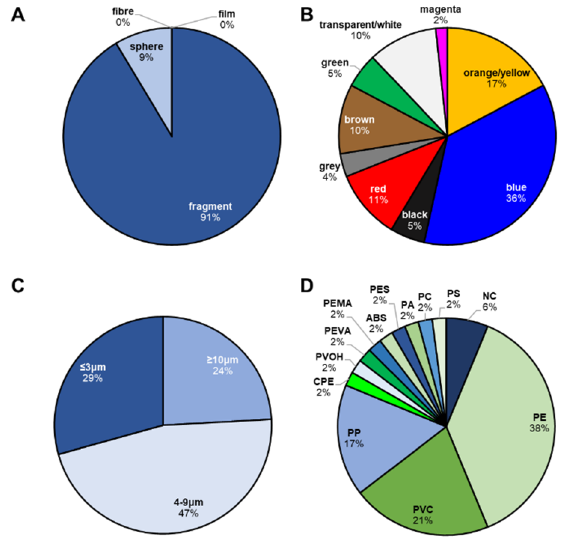
Figure 2. Percentage abundances of identified shapes ( A ), colours ( B ), dimensions ( C ), and polymer matrices ( D ). PE: polyethylene; PVC: polyvinyl chloride; PP: polypropylene; CPE: chlorinated polyethylene; PVOH: polyvinyl alcohol; PEVA: poly(ethylene-co-vinyl acetate); PEMA: poly(ethyl methacrylate); ABS: acrylonitrile butadiene styrene; PES: polyester; PA: polyamide; PC: polycarbonate; PS: polystyrene, and NC: nitrocellulose.